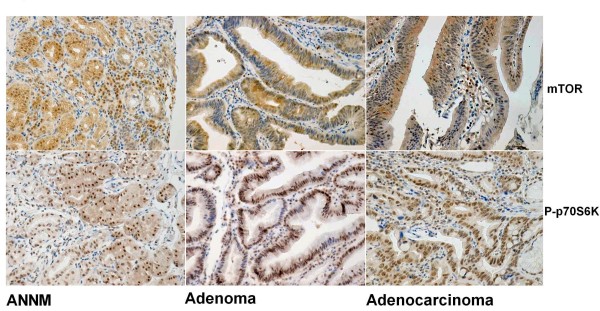
Immunohistochemical staining in gastritis, gastric adenoma and carcinoma. Note mTOR positivity was strongly observed in the cytoplasm, while P70S6K in the cytoplasm and nucleus. mTOR expression was observed in non-cancerous mucosa (a, +++), adenoma (b, +++) and carcinoma(c, +++). P70S6K protein was immunoreactive in non-neoplastic mucosa (d, +++), adenoma (e, +++) and carcinoma (f, +++).